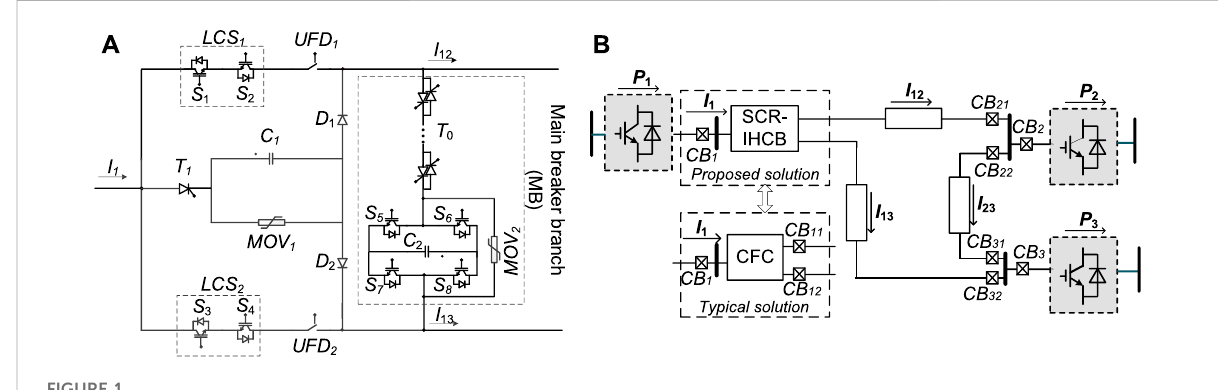
FIGURE 1 Proposed SCR-IHCB topology and installation position in system. (A) Proposed topology; (B) Three-terminal meshed HVDC system under study.